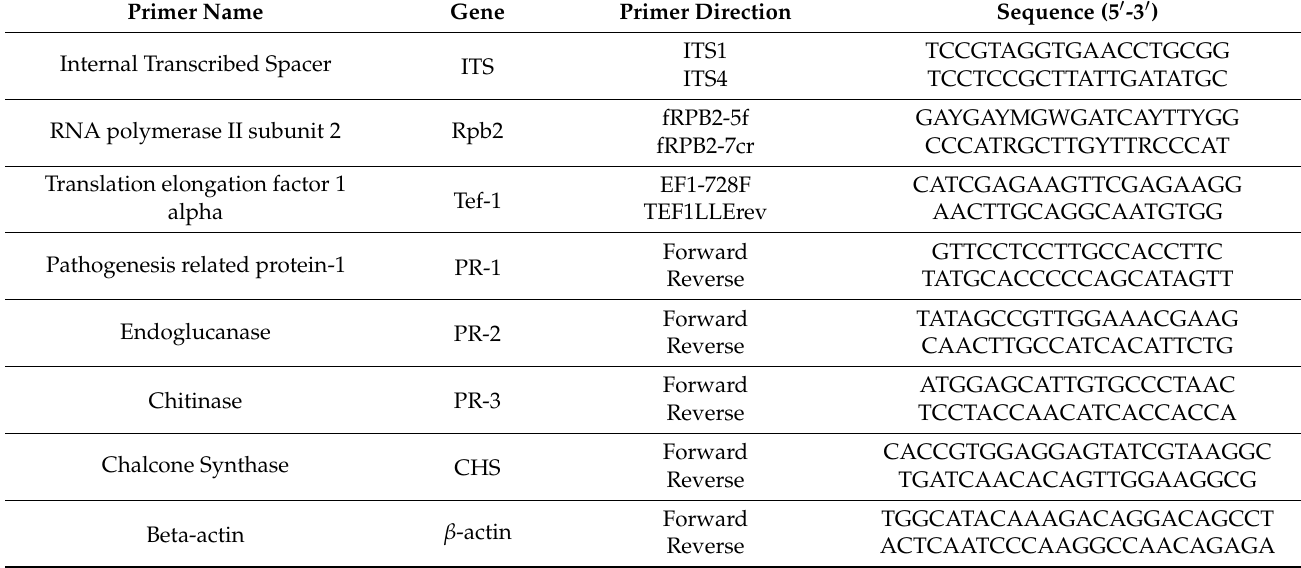
Table 1. Primer nucleotide sequences used in this